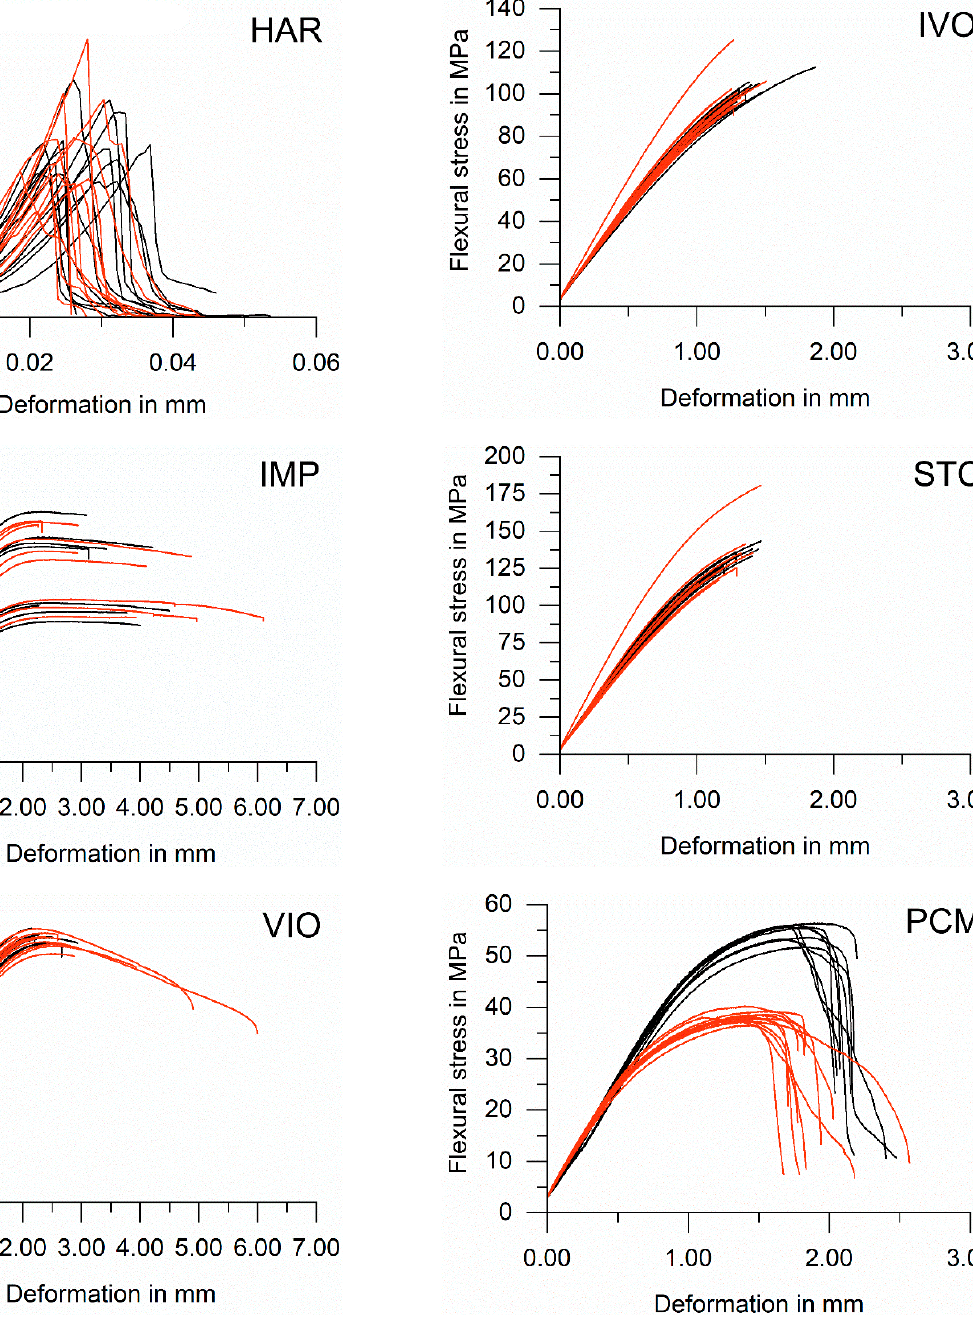
Figure 2. Deformation and flexural stress relations for materials exposed to X-ray irradiation during µXCT measurements (red) and unexposed specimens (black). Each curve describes the behaviour of a single sample. A total of 10 irradiated and 10 non-irradiated samples per material were tested.